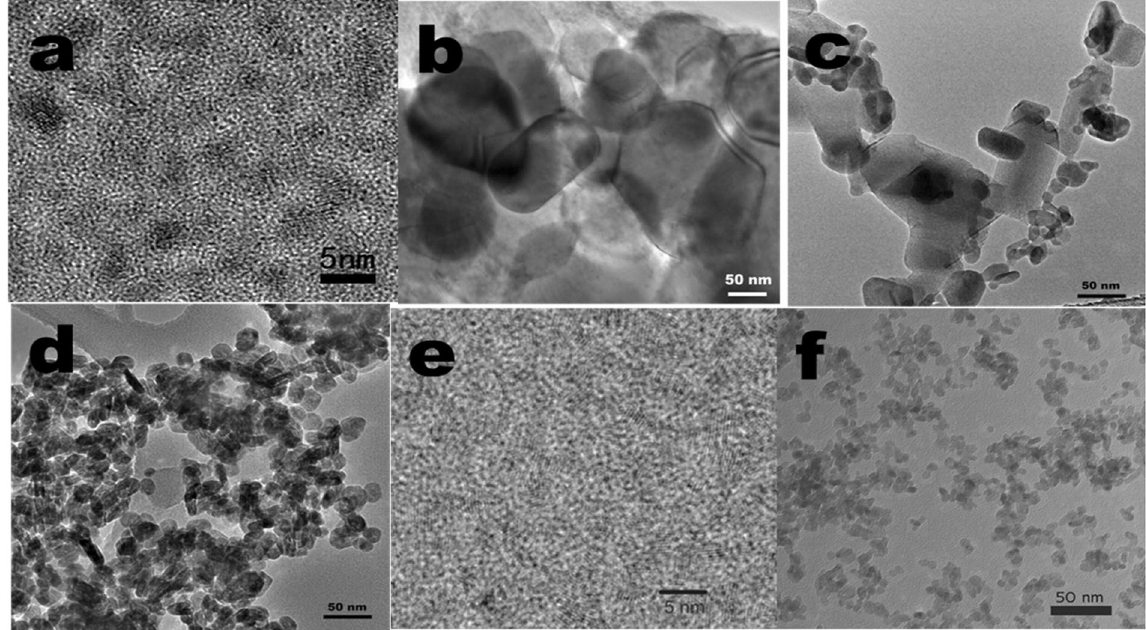
Figure 2. TEM images of ( a ) CdS, ( b ) Cu-Cy, ( c ) ZnS:Mn,Eu, ( d ) ZnS:Mn, ( e ) CdTe, and ( f ) La x Ce 1 − x F 3 (0 ≤ x < 1).